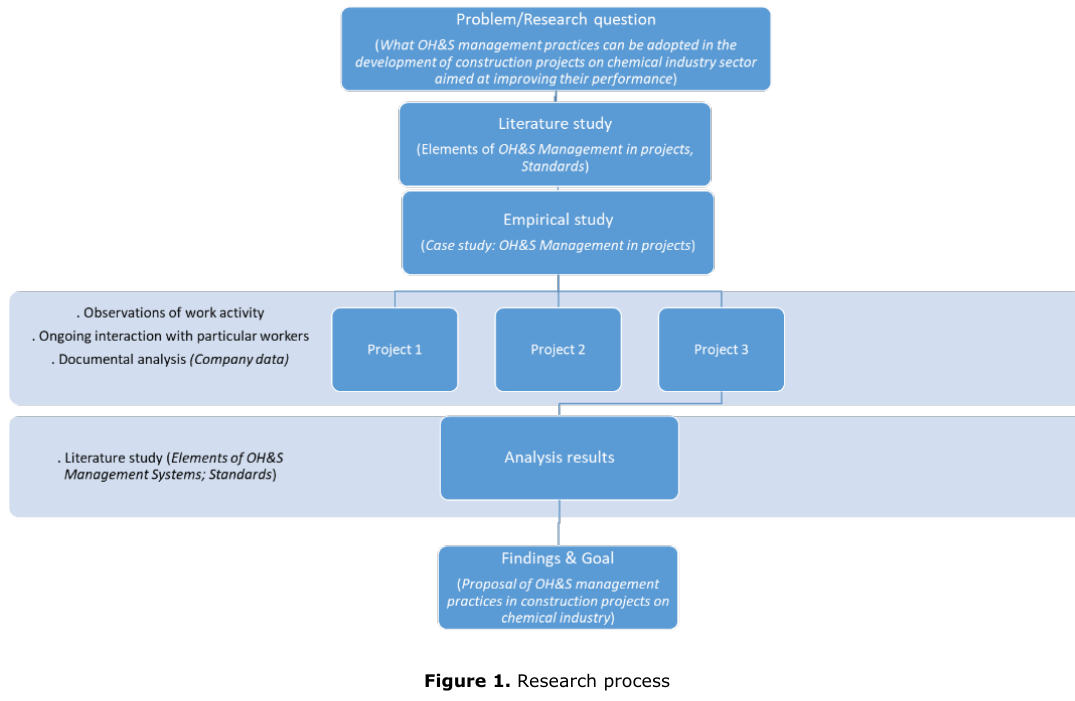
Figure 1. Research